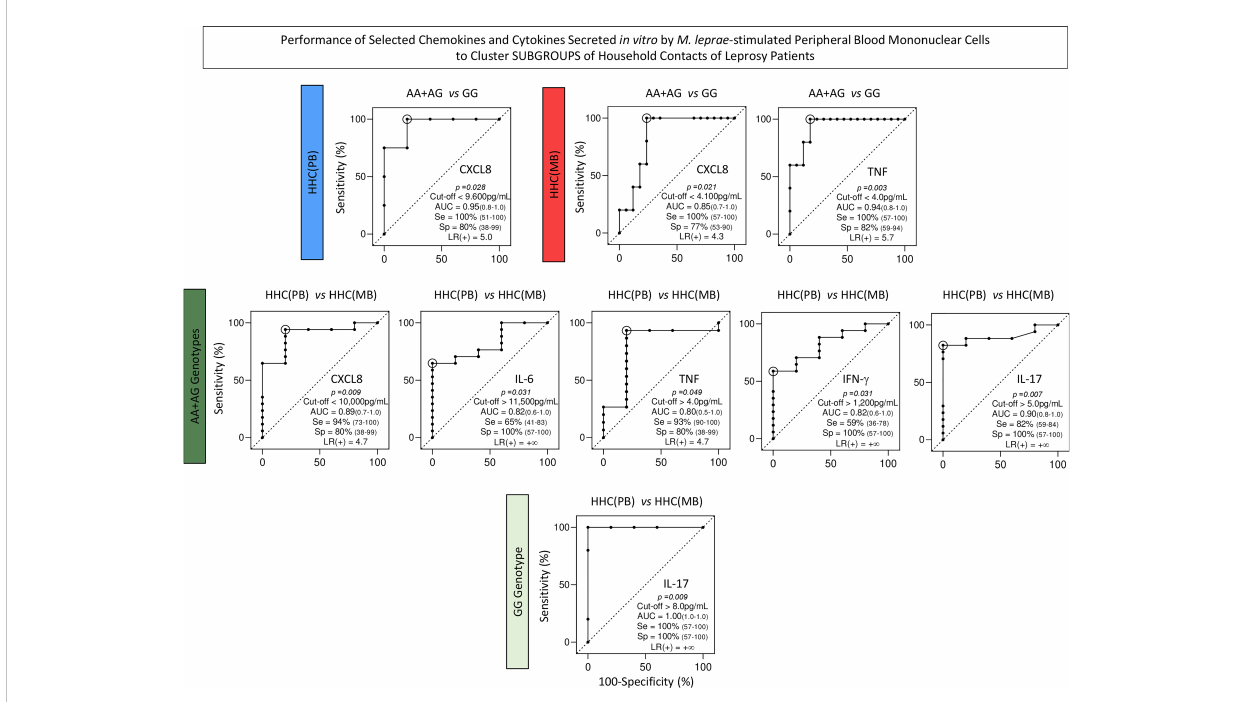
FIGURE 9 Performance of selected chemokines and cytokines secreted in vitro by M. leprae-stimulated peripheral blood mononuclear cells to cluster subgroups of household contacts of leprosy patients. Receiver-operating Characteristic Curves (ROC) were constructed to demonstrate the performance indices for selected chemokines and cytokines (CXCL8, IL-6, TNF, IFN- g and IL-17) to cluster subgroups of household contacts of paucibacillary [HHC(PB) = ] and multibacillary patients [HHC(MB) = ] according to the TLR4 rs1927914 dominant genetic model (AA+AG = and GG = ). The p values, cut-offs, area under the ROC curve (AUC) with 95% con fi dence interval (95%CI), sensitivity (Se, 95%CI), speci fi city (Sp, 95%CI) and likelihood ratio (LR) are provided in the fi gure. LR = + ∞ represents an in fi nite likelihood